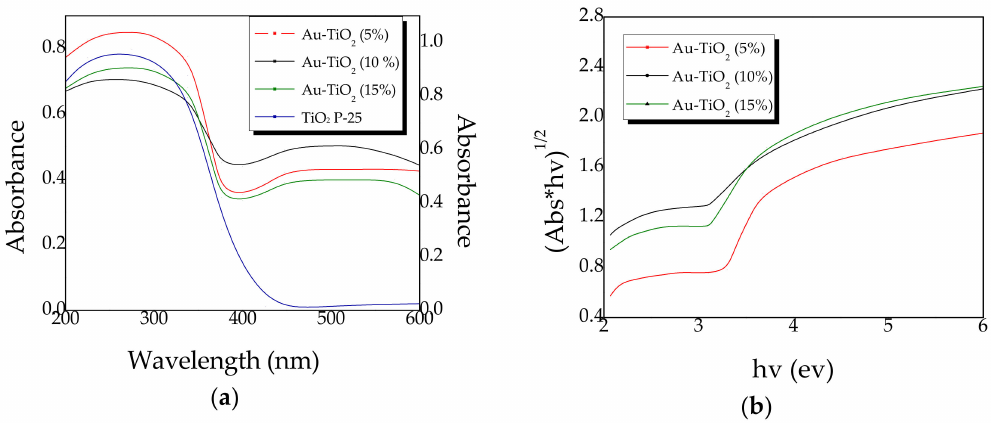
Figure 3. ( a ) Kubelka Munk plots of the Au-TiO 2 catalysts and the TiO 2 P-25 catalyst. ( b ) Normalization of di ff use reflectance data for band gap calculation.